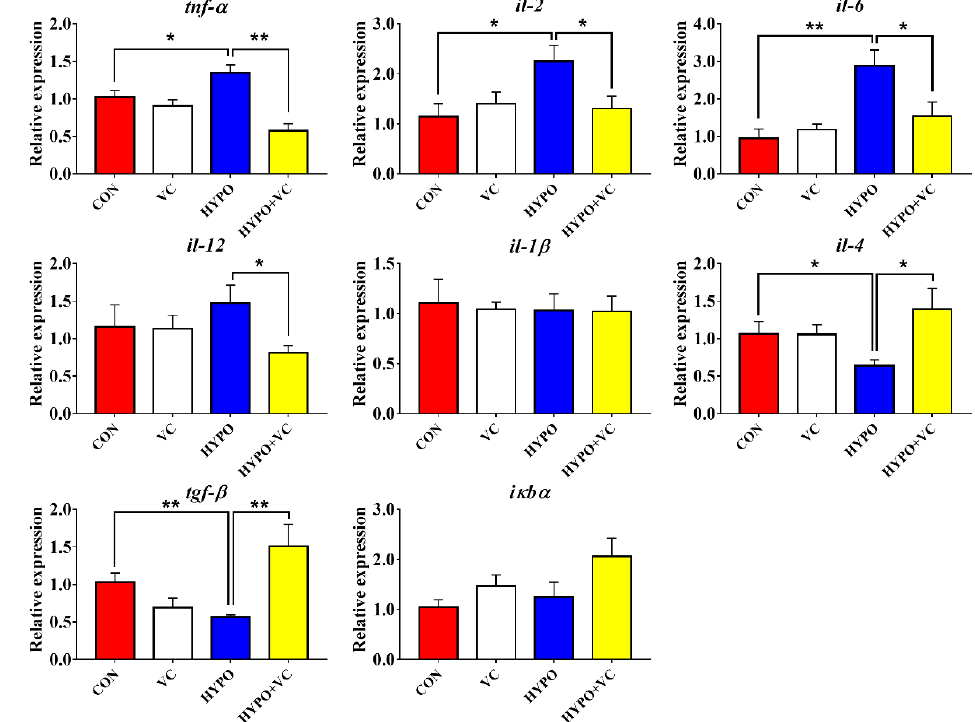
Figure 5. Changes of inflammation-related genes in the liver of gibel carp in the normal and hypoxia groups after 56 days of feeding with VC. The * or ** at the top of the bar chart indicates significant differences between treatments; * indicates a significant difference ( p < 0.05), and ** indicates the extremely significant difference ( p < 0.01). All of the data are presented as the mean ± standard error (n = 6). tnf- α — tumor necrosis factor- α; il-2 — interleukin 2; il-6 — interleukin 6; il-12 — interleukin 12; il- 1β — interleukin 1β; tgf- β — transforming growth factor- β; il-4 — interleukin 4; iκbα — nf- κb inhibitorα.